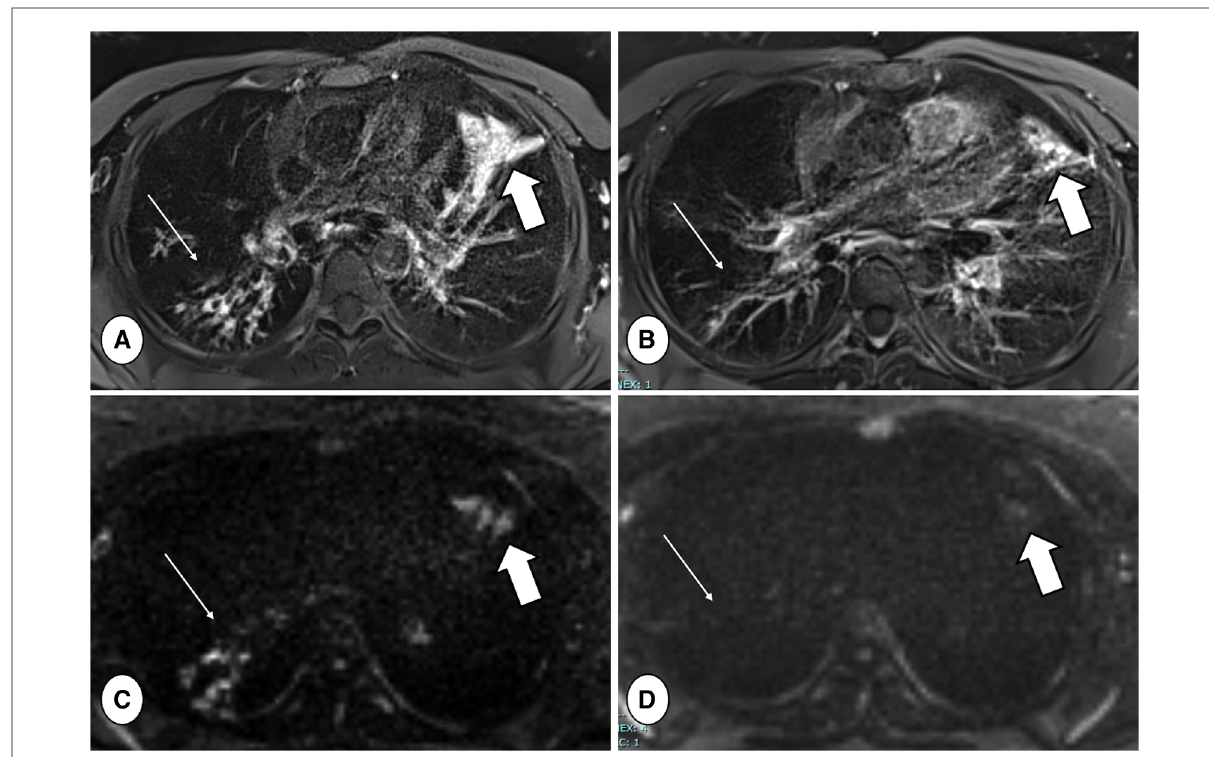
FIGURE 6 Axial proton density-weighted PROPELLER free-breathing scan ( A,B ) and diffusion-weighted imaging (DWI) (b=800 mm/s 2 ) acquisition ( C,D ), both performed with a 1.5 T MRI system (MAGNETOM avanto, siemens healthineers, enlargen, Germany), in a patient with CF during respiratory tract exacerbation at baseline ( A,C ) and after treatment ( B,D ). Note the reduction in mucus plugs and DWI signal in the right lower lobe between baseline and follow-up (thin arrows), as well as the reduced consolidation and DWI signal in the lingula (thick arrows).